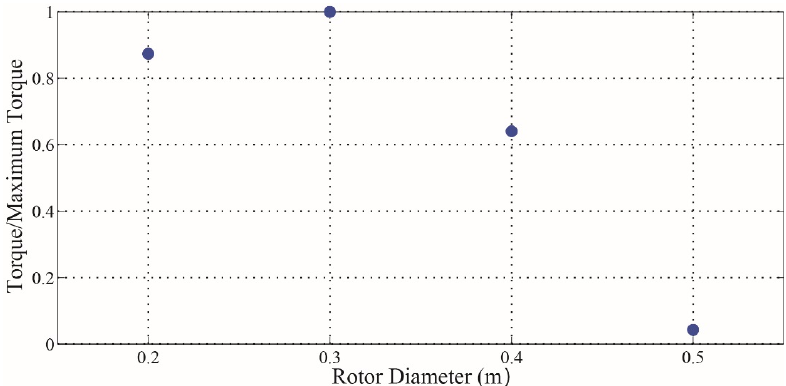
Figure 8. Torque generated on the center of the rotor